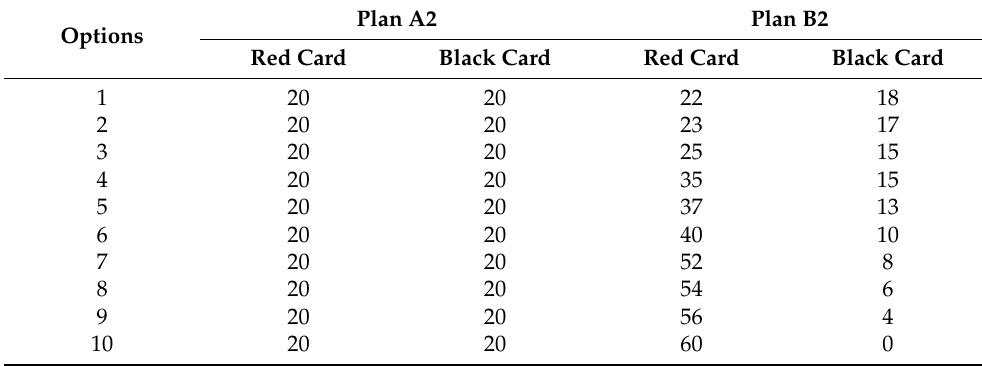
Table A2. Experimental protocol. Plan A2 Plan B2 Options Red Card Black Card Red Card